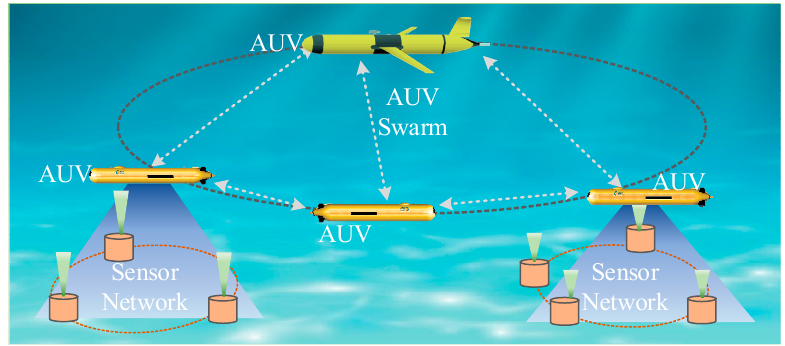
Figure 1. Conception of AUV swarm collaborative operation.